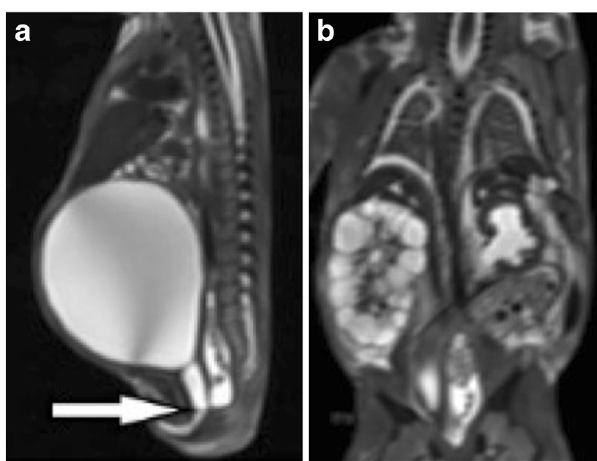
Fig.9 PMFMRIofan 18weeks gestationfetusina caseoftermination of pregnancy. a Sagittal T2-W image shows a megabladder and dilated posterior urethra above the posterior urethral valves (arrow). b Coronal T2-W image shows a right multicystic dysplastic kidney and left